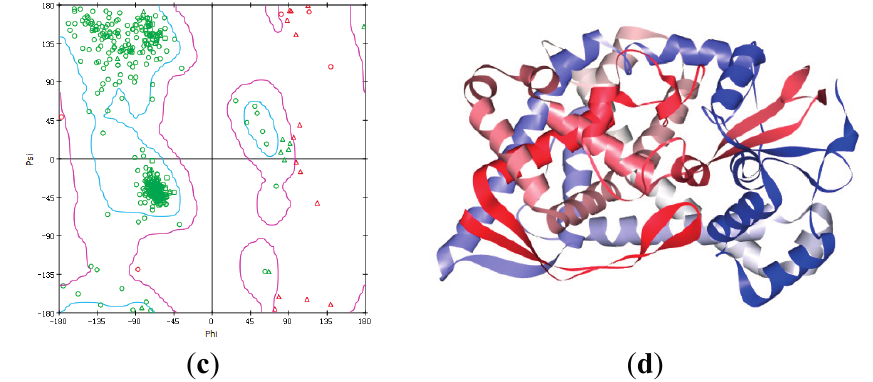
Figure 5. Structural-based alignment of CYP11B1 and the template PDB ID: 4DVQ-A. ( a ) The sequence shaded in cyan represents sequence similarity; ( b ) Superposition of the predicted CYP11B1model onto to the template PDB ID: 4DVQ-A, yellow indicates template, blue indicates predicted model; ( c ) Ramachandran Plot of the best CYP11B1 model; ( d ) Structure of the best predicted